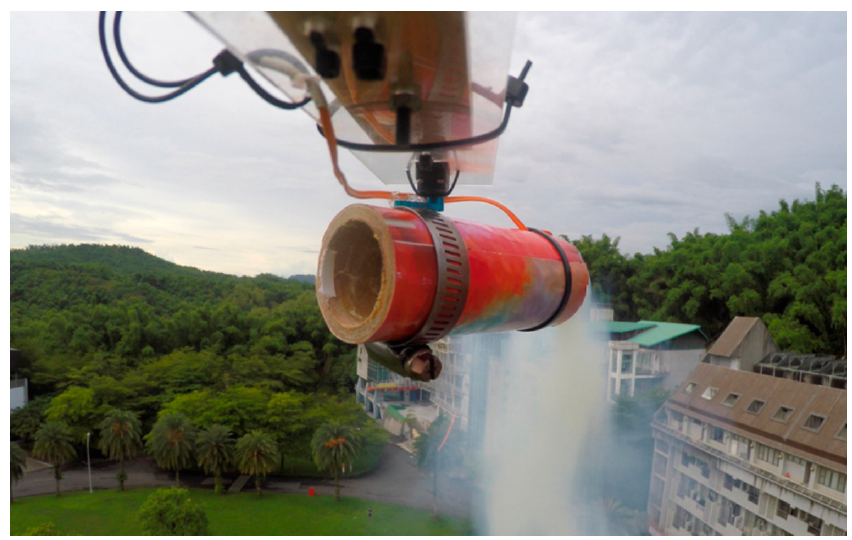
Figure 10. The smoke tube shifted to the left.